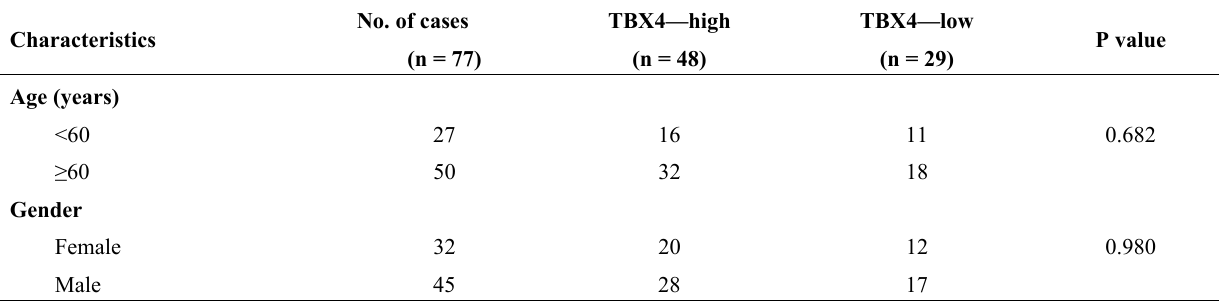
Table 1. Clinicopathological features and correlation of TBX4 expression in stage II